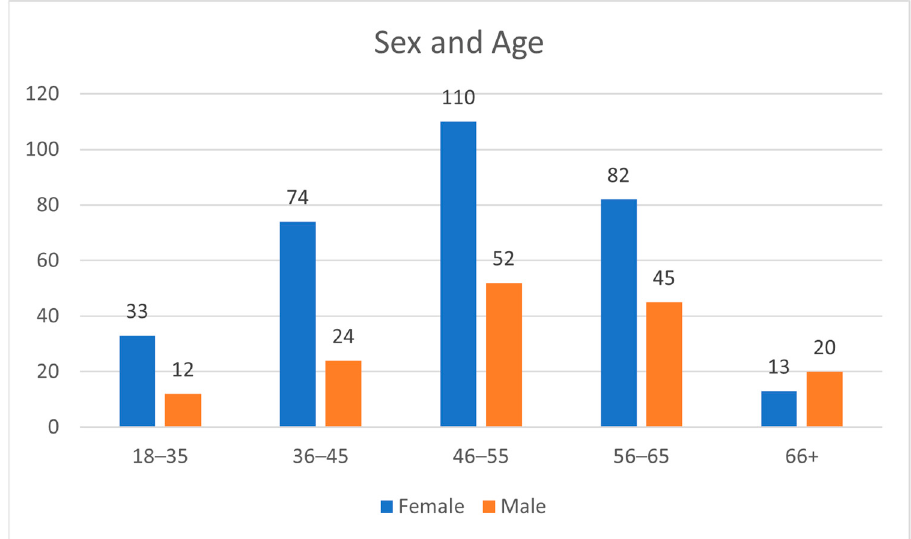
Figure 1. Numbers of respondents in age bands and by sex (Q2 and Q3).